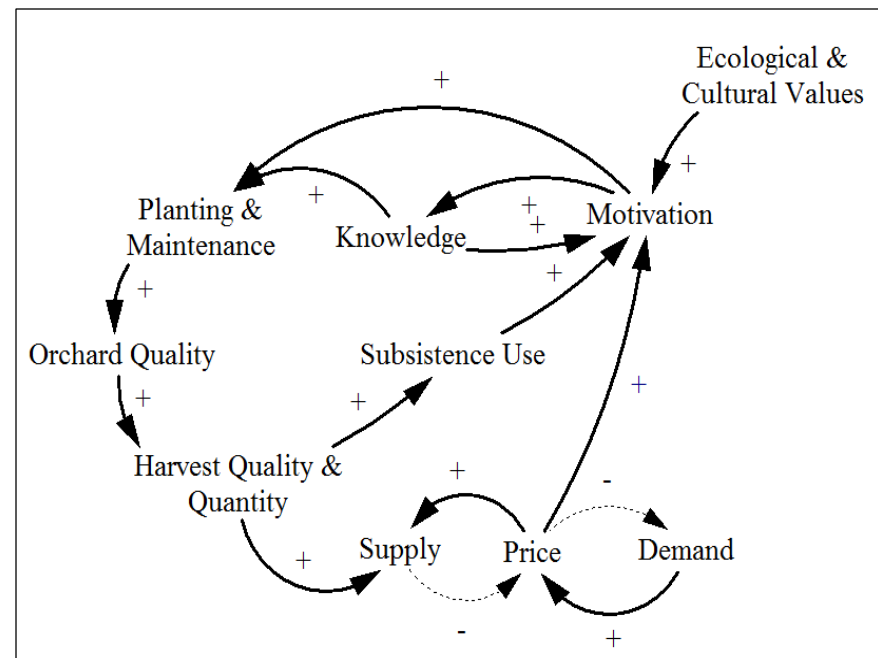
Figure 5. Market and Nonmarket Variables that Impact Producer Motivation To Plant and Maintain Orchard